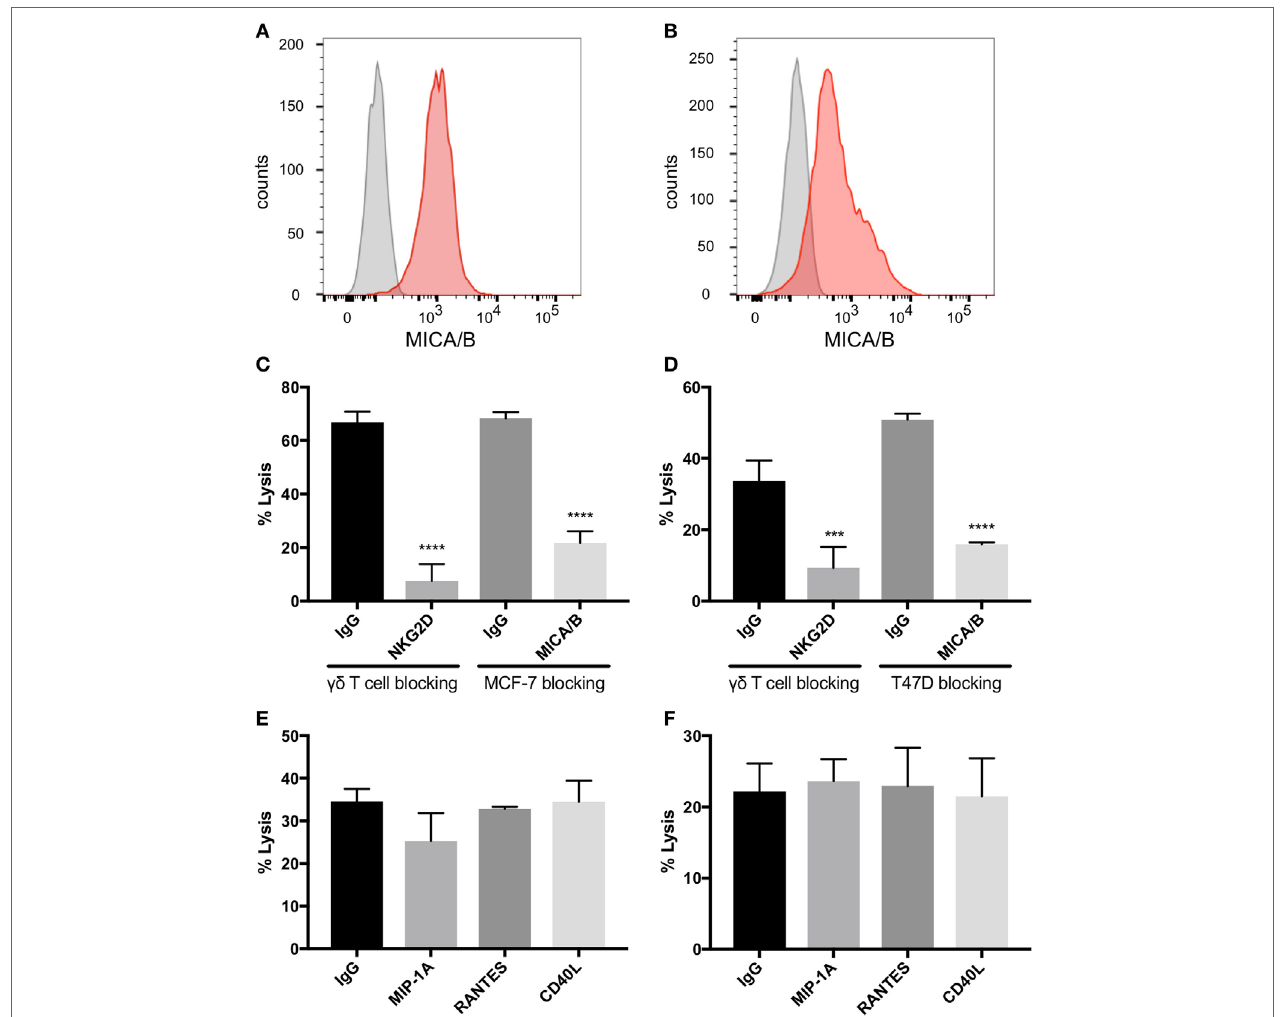
FigUre 4 | Natural killer group 2, member D (NKG2D) on gamma delta T cells ( γδ Tcs) and MHC class I polypeptide-related sequence A (MICA)/B on breast cancer cell lines